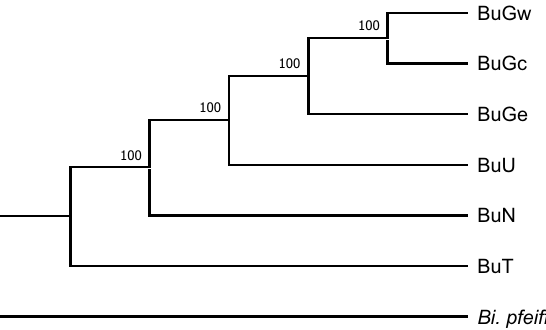
Figure 3. A maximum likelihood (ML) phylogenetic tree with 1000 bootstrap replicates of full-length mitochondrial genome nucleotide sequences of Bulinus species. All bootstrap values are indicated at supported